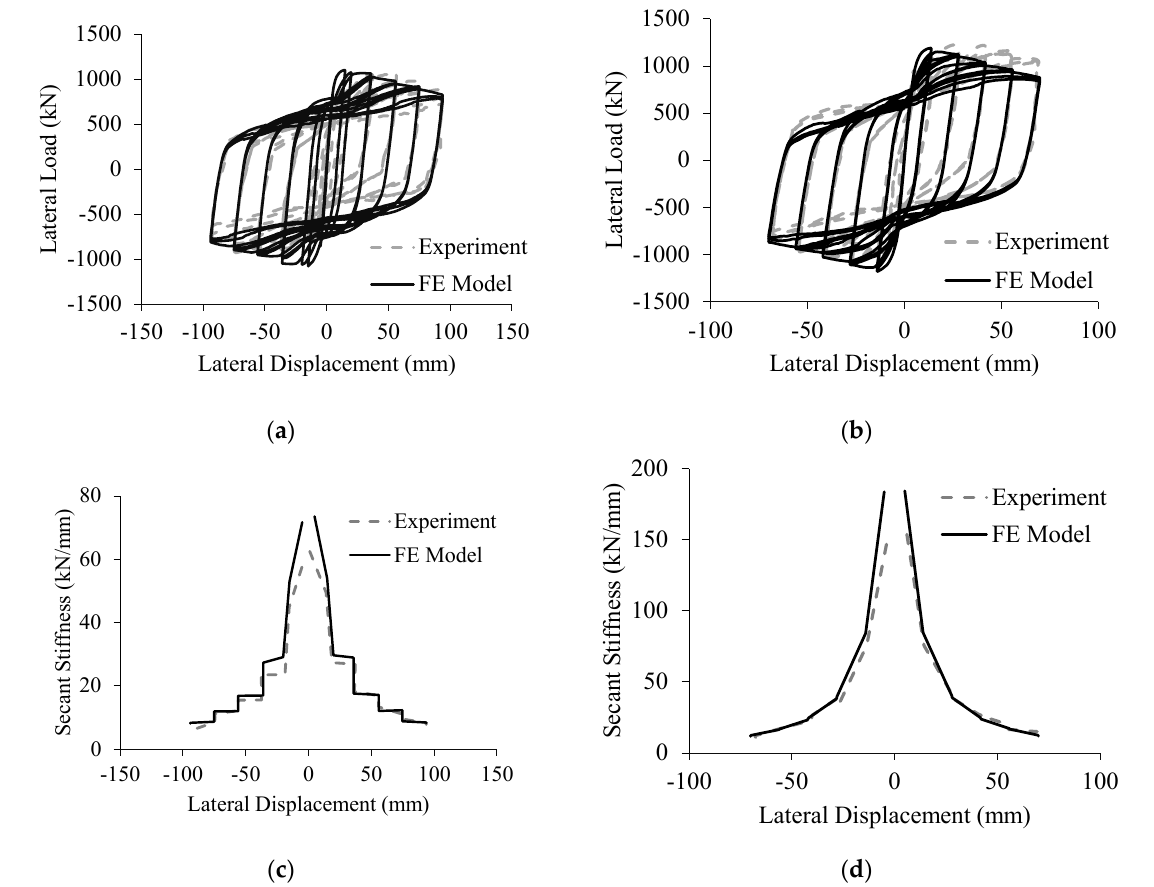
Figure 5. Comparison of experimental and simulation results: load–displacement hysteresis curves of specimen ( a ) GSPCW-1 and ( b ) GSPCW-2; secant stiffness degradation of specimen ( c ) GSPCW-1 and ( d ) GSPCW-2. Table 2. Comparison of characteristic points of skeleton curves.